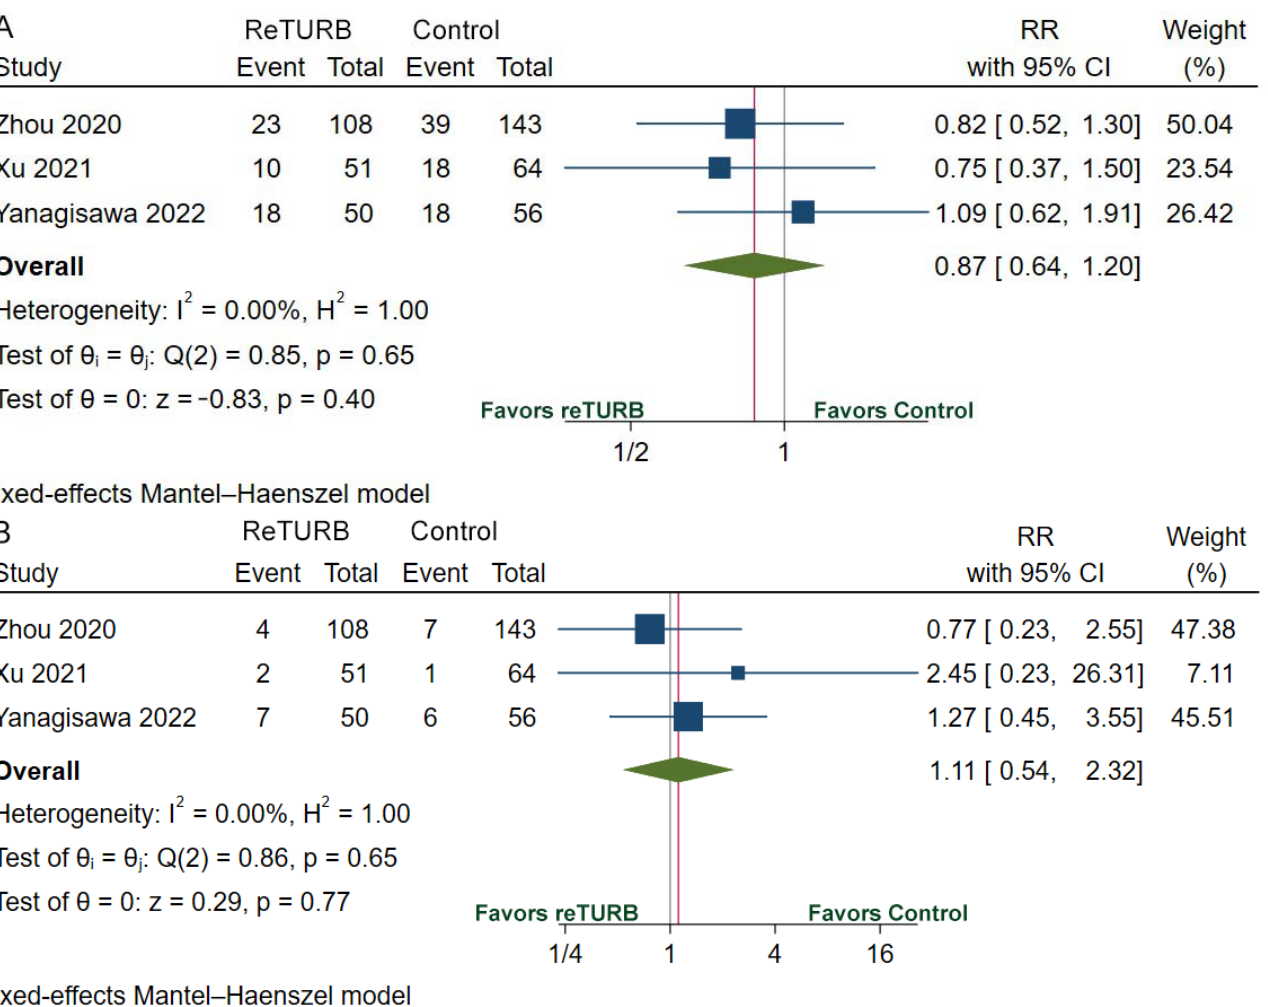
Figure 3. Forests plots of comparisons of 1 ‐ year RFS ( A ), 2 ‐ year RFS ( B ), 3 ‐ year RFS ( C ), and 5 ‐ year RFS ( D ) between the reTURB group and control group [32,36,38]. The gray lines represent the reference lines and the red lines show the pooled effect sizes. RFS: recurrence ‐ free survival; HR: hazard ratio; reTURB: repeat transurethral resection of bladder tumors; CI: confidence interval.